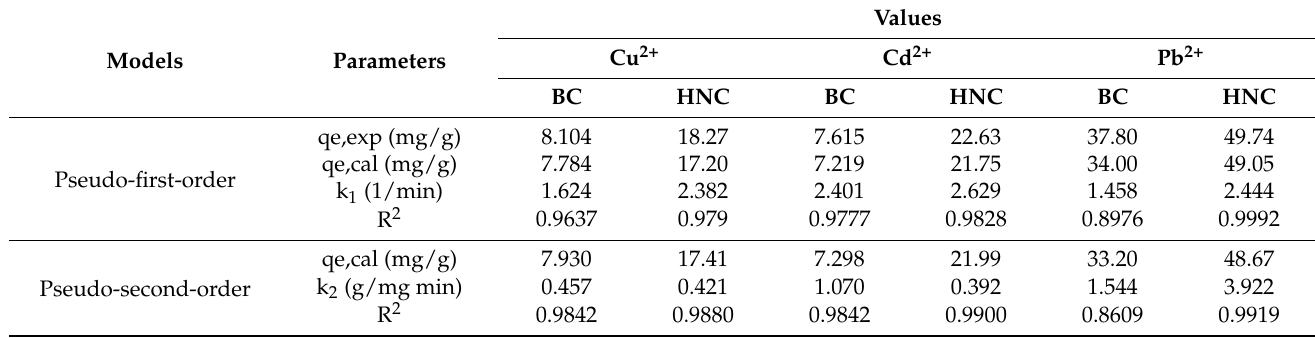
Table 2. Kinetic parameters for the adsorption of Cu 2+ , Cd 2+ and Pb 2+ by BC and HNC.